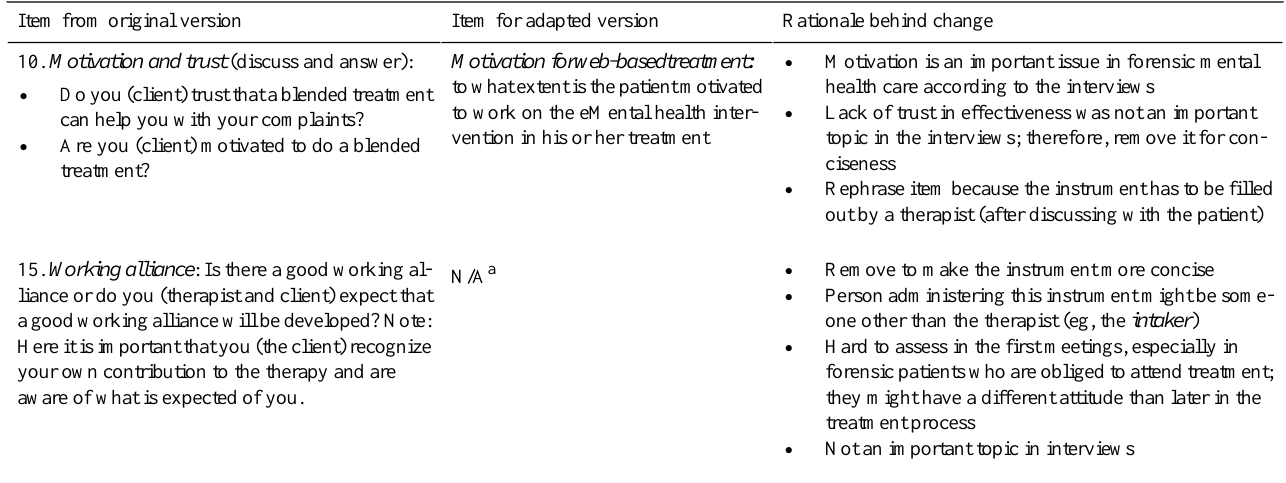
Table 4. Examples of the table used to create items of the adapted version based on the original version of the Fit for Blended Care instrument.